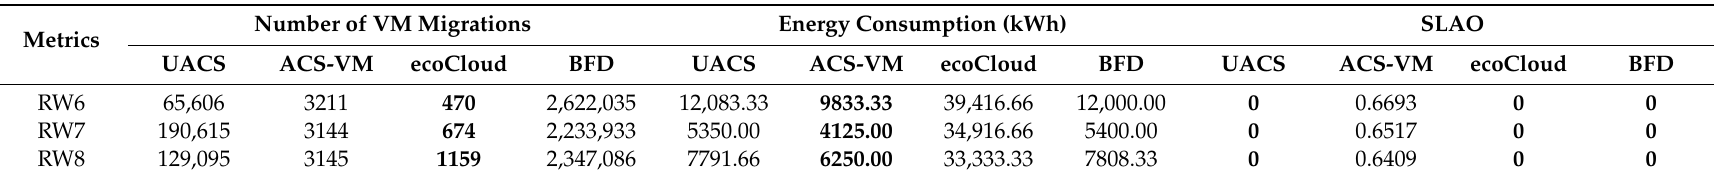
The results with boldface are the best results among the compared